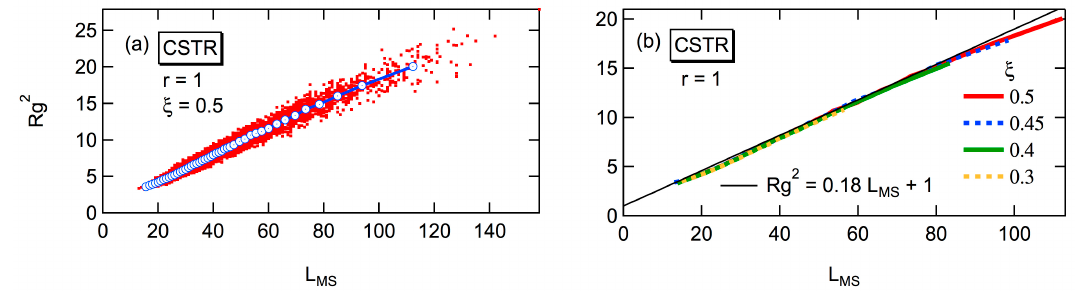
Figure 25. Relationship between Rg 2 and L MS for a CSTR with r = 1. ( a ) Raw data and the averages within Δ L MS , i.e., the expected Rg 2 -values, at x A = 0.95. ( b ) Expected Rg 2 for various conversion levels.